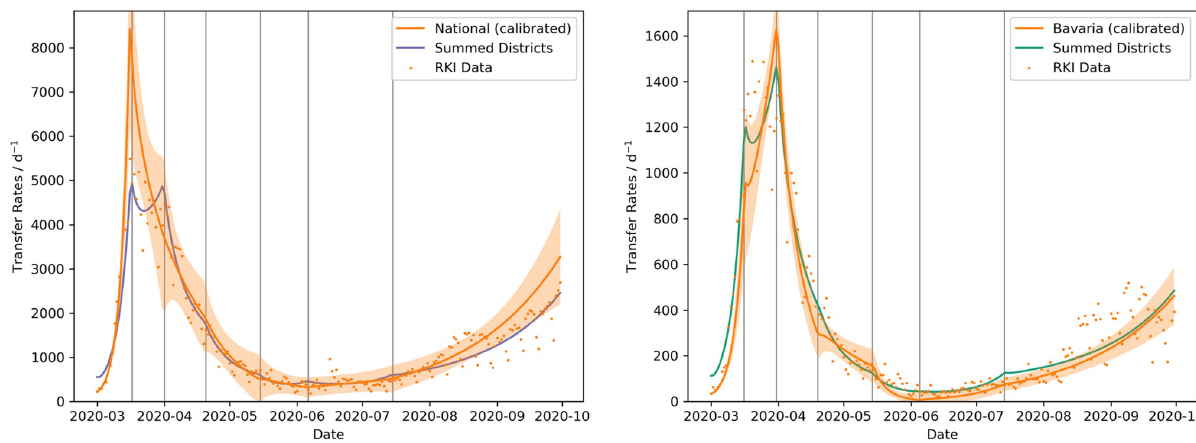
Fig 3. Comparison of fitted model results on different hierarchical levels. Comparisons of parametrized model runs on a higher hierarchical level with the aggregated case numbers from the fitted district level models. The fitted national model and the summed positive cases resulting from the 412 district level models are compared to the nationwide reported cases in the left panel and the fitted state model of Bavaria and the summed positive cases resulting from its 96 district level models are compared to the reported cases in Bavaria in the right panel. The shaded area indicates the 95% credible interval. The vertical grey lines indicate the dates of the